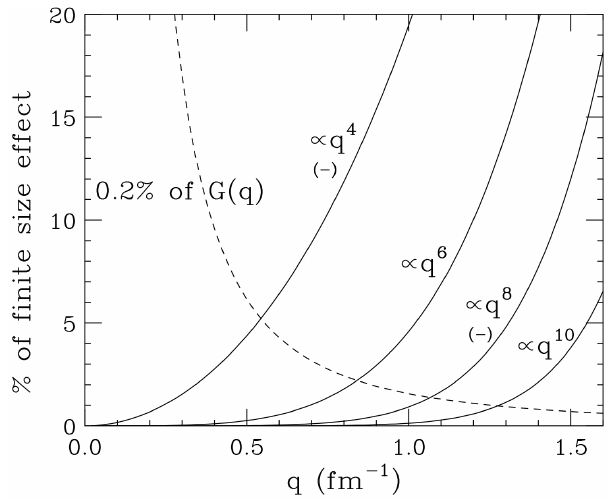
Figure 7. Relative contribution in % of the (cid:104) r 2 n (cid:105) terms to the finite size effect 1 − G ( q ) , calculated using the moments of